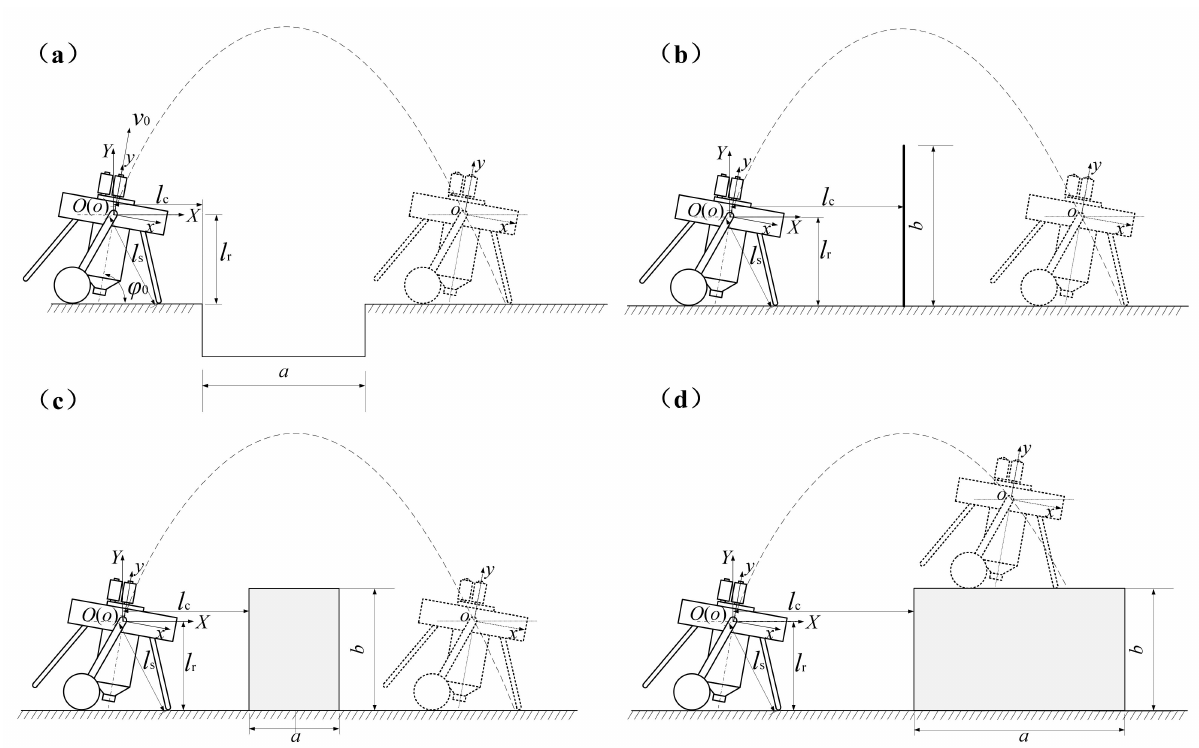
Figure 3. The schematic diagram of jumping robot’s overcoming different obstacles. ( a ) Jumping robot jumps over ditch. ( b ) Jumping robot jumps over wall. ( c ) Jumping robot jumps over platform. ( d ) Jumping robot jumps onto